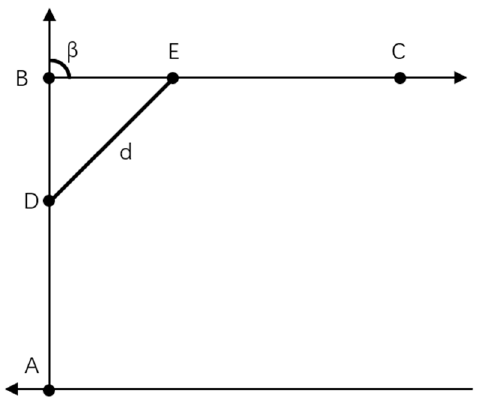
Figure 4. Deviation between trajectory and straight-line path.